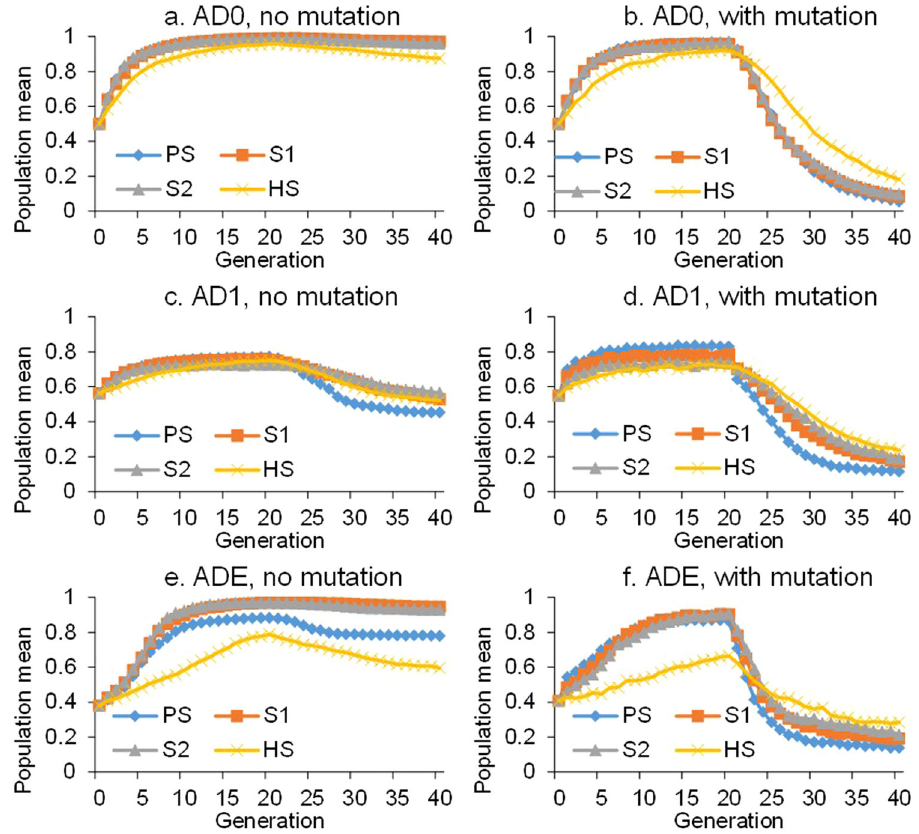
Fig. 2 Population mean during 20 cycles of forward selection and 20 cycles of reverse selection. Three biallelic genetic models were considered, i.e., AD0 (additive model), AD1 (additive and dominant model) and ADE (additive, dominant and epistatic model). Four selection methods are simulated, i.e., phenotypic selection (PS), S1 family selection (S1), S2 family selection (S2), and half-sib selection (HS). a Model AD0 and no mutation was considered. b Model AD0 and mutation was considered. c Model AD1 and no mutation was considered. d Model AD1 and mutation was considered. e Model ADE and no mutation was considered. f Model ADE and mutation was